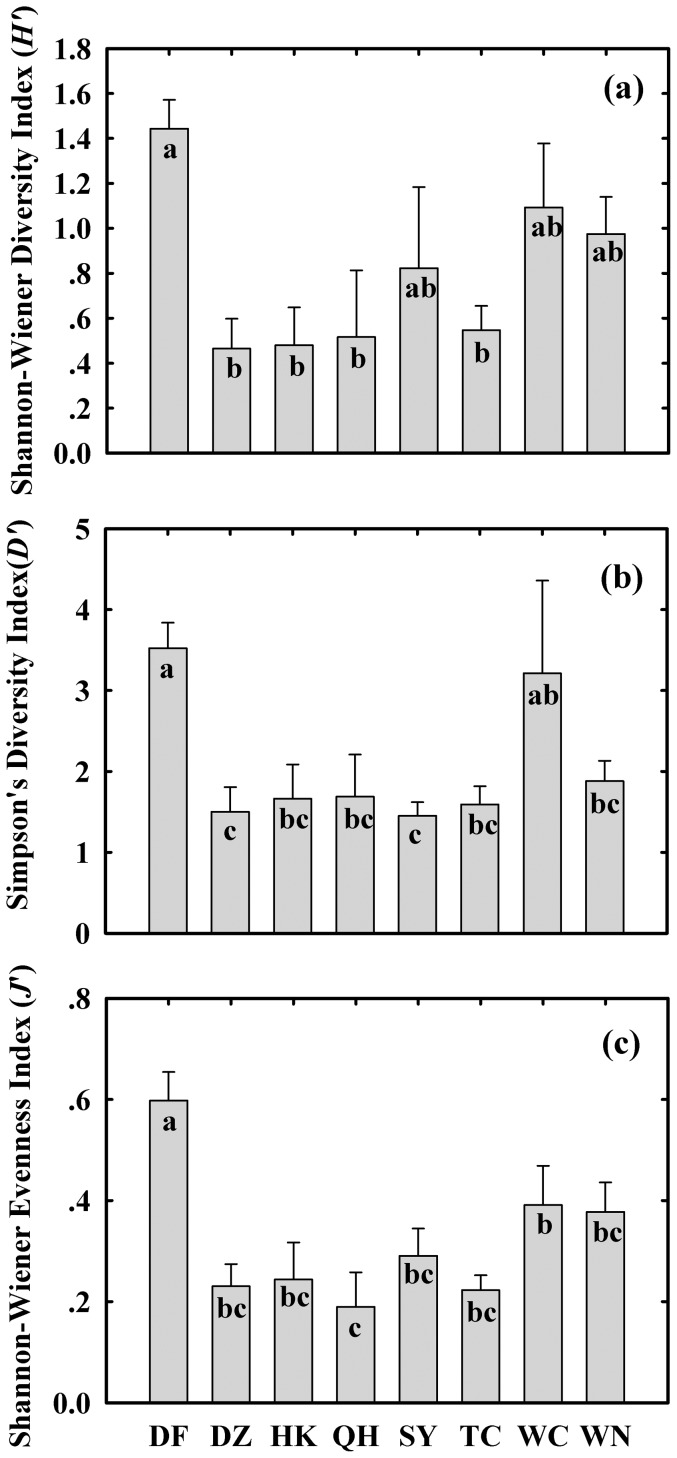
Mean biodiversity of the plant communities among eight cities across Hainan.(a): Shannon-Wiener's species diversity index (H′); (b): Simpson's dominance index (D′); (c): Shannon-Wiener's evenness index (J′). For each variable, means labeled with the same letter are not significantly different according to Duncan's multiple-range test at the p = 0.05 level.